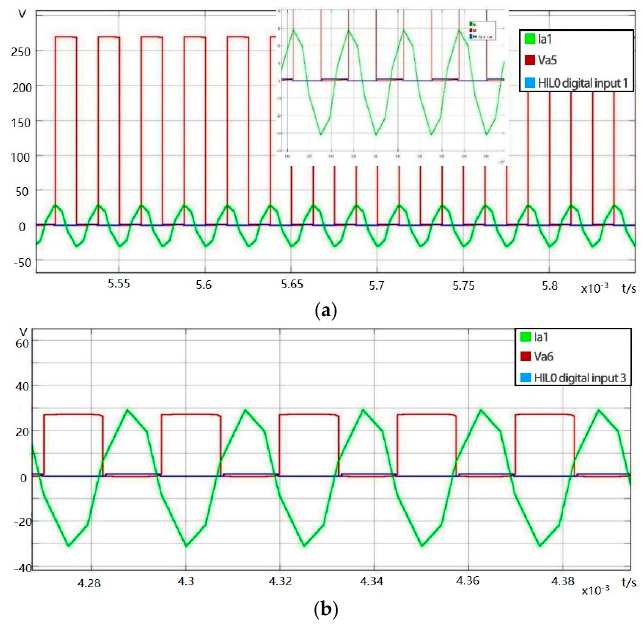
Figure 13. Realization of soft switch ( a ); turn on waveform of S 1 ( b ) turn on waveform of Q 1 .